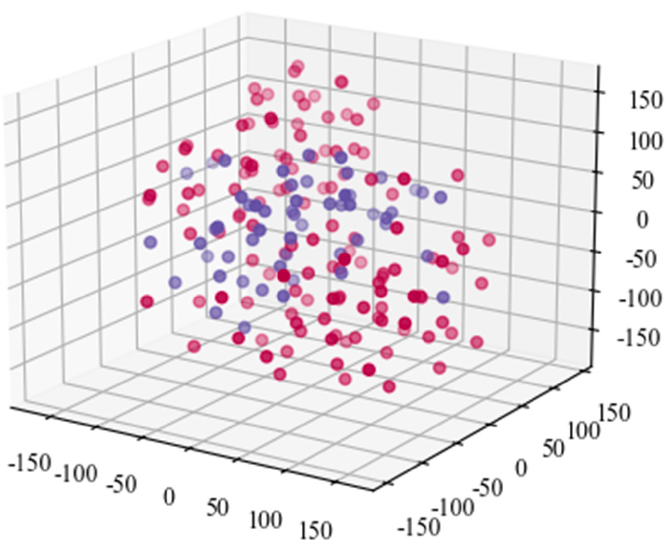
Figure 16. The diagram of the collected acoustic signal data after TSNE processing.